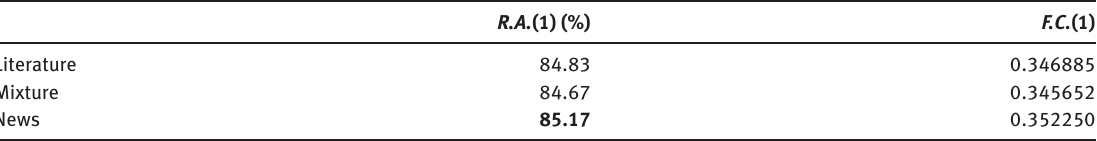
Bold values mean the best results. Table 6: Results of Conventional LSI.